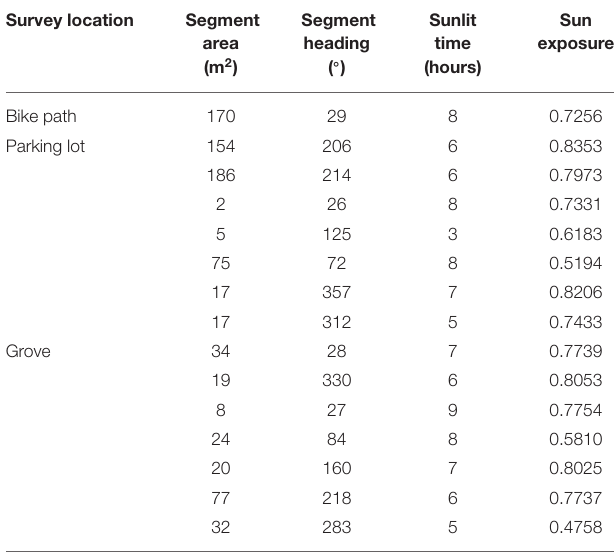
TABLE 2 | Summary of the data used to model the impact edge effect has on invasive